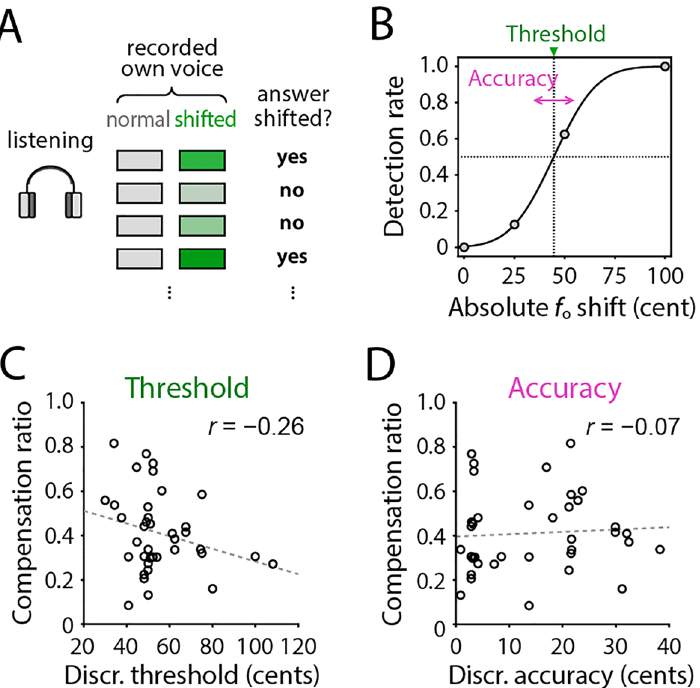
Figure 5. Participants’ ability to detect the f o shifts in recorded own voices, and its correlation with the compensation ratio. ( A ) Test procedure. Participants listened to a pair of recorded voices corresponding to the first and second vocalization in each of the vocalization trials, and judged whether the second one had any modification in pitch or not. ( B ) Estimation of the detection threshold and accuracy by fitting a sigmoid function. ( C , D ) Correlations of the compensation ratios with the detection threshold ( C ) and accuracy ( D ). r shows Pearson’s correlation